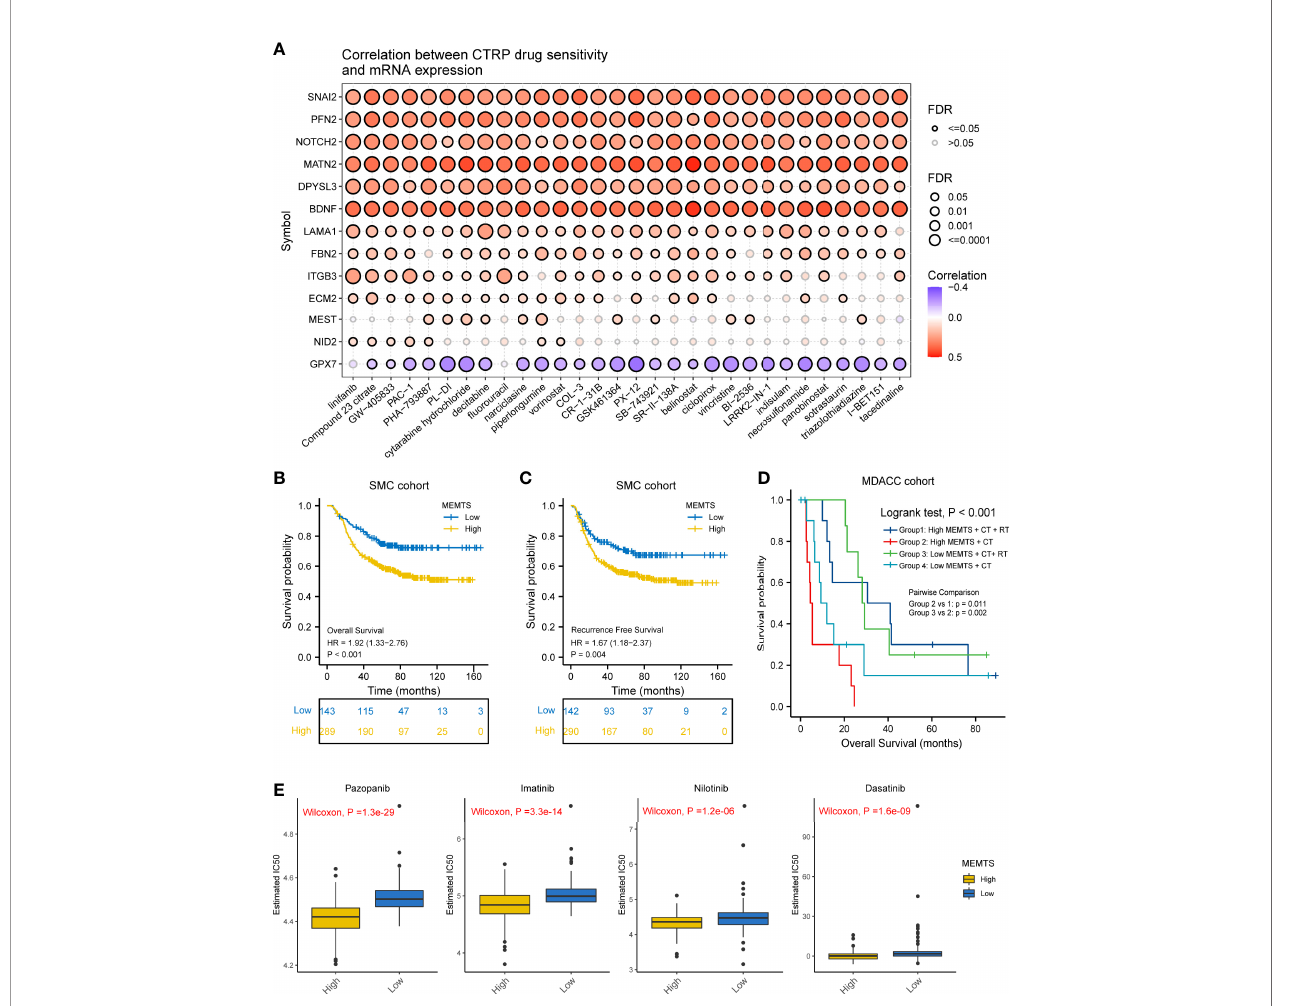
FIGURE 4 | Prediction and correlation of the sensitivity to chemotherapy drugs in gastric cancer. (A) The correlation between GDSC drug sensitivity and hub genes expression. (B) Kaplan – Meier survival plots showing the differences of overall survival and recurrence free survival between high and low MEMTS. (C) Postoperative chemoradiotherapy can signi fi cantly improve the prognosis of patients with high and low IMS compared to chemotherapy. (D) Kaplan – Meier plot showing the OS of low and high subgroup strati fi ed by MEMTS in patients treated with neoadjuvant chemotherapy or neoadjuvant chemoradiotherapy (MDACC cohort). (E) The high MEMTS subtype was related to the lower IC50 of multiple targeted drugs including pazopanib, imatinib, nilotinib, and